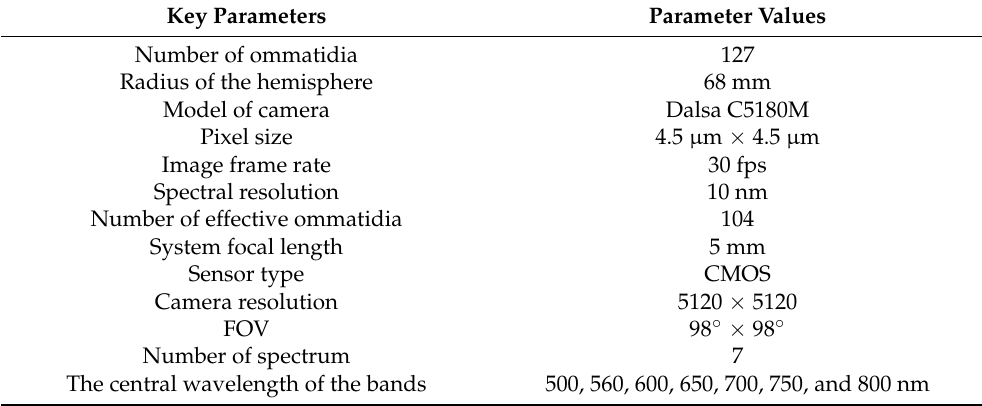
Table 9. Specifications of BMCCEC.